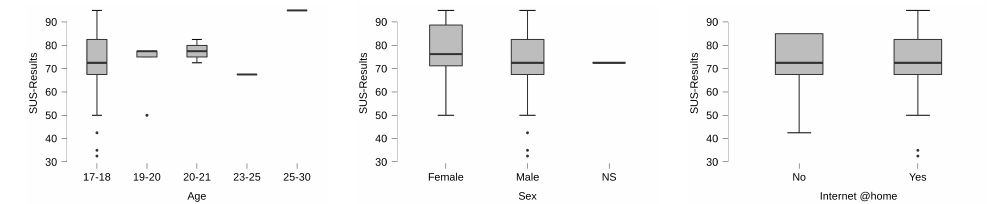
Figure 6. SUS boxplots: ( left ) by age, ( middle ) by gender, ( right ) by internet